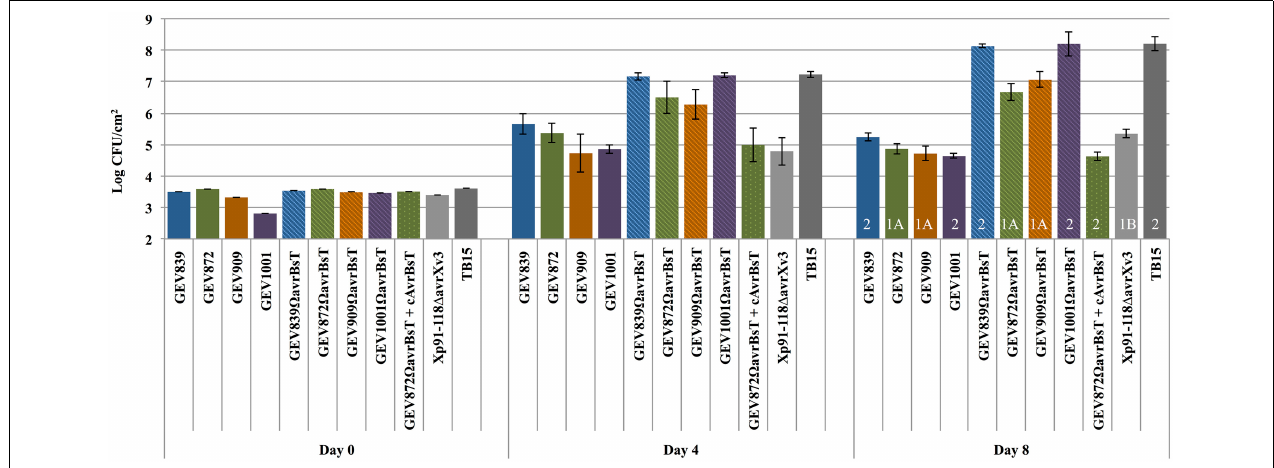
FIGURE 4 | Role of avrBsT as host range determinant on pepper cv. Early CalWonder. In planta growth of X. perforans strains and avrBsT insertion mutants was measured at different time points (days 0, 4, and 8)